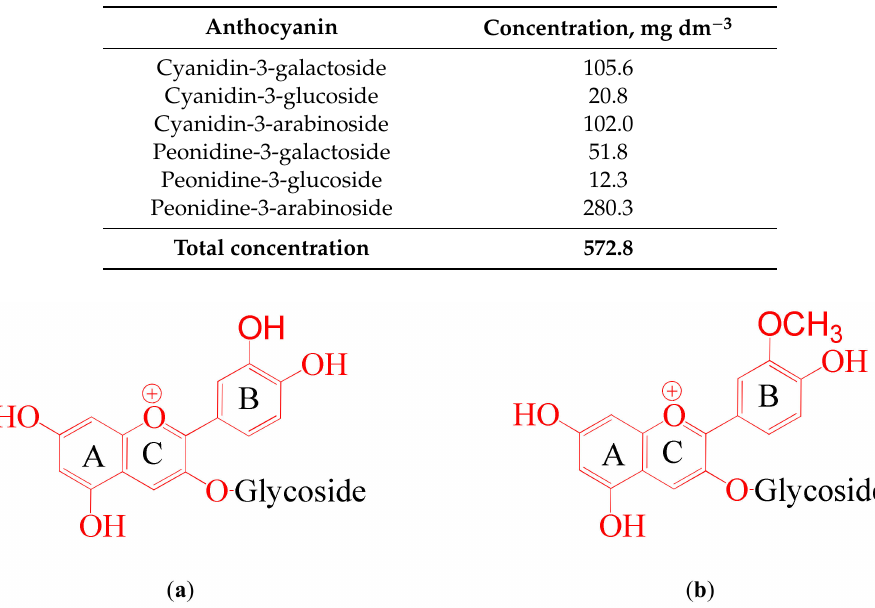
Figure 2. Structure of anthocyanins: cyanidin ( a ) and peonidin ( b ), contained in the external solution at pH 3. Redrawn from reference [1]. Glycoside is glucose, arabinose, or